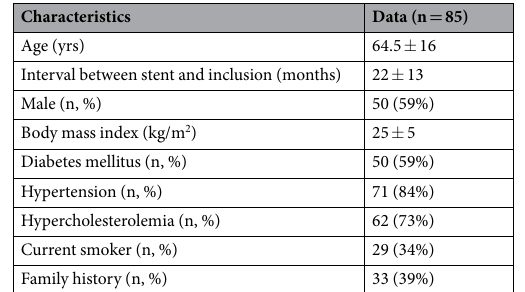
Table 1. Patients’ clinical parameters. Values are n, mean ± SD or n (%).